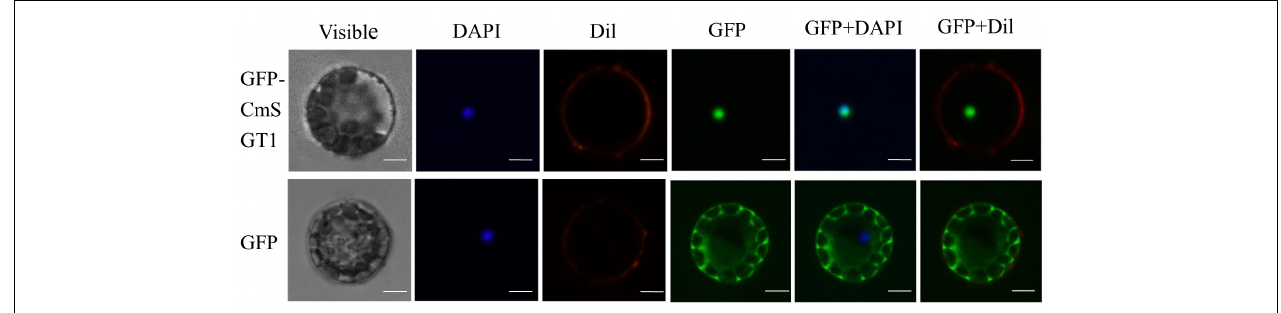
FIGURE 1 | The subcellular localization of pumpkin CmSGT1. The fused pBI221-GFP- CmSGT1 and pBI221-GFP constructs were introduced into Arabidopsis protoplast by polyethylene glycol (PEG)-mediated protoplast transformation. The fluorescent signals were detected using a confocal fluorescence microscope. Scale bars = 5 µ m.